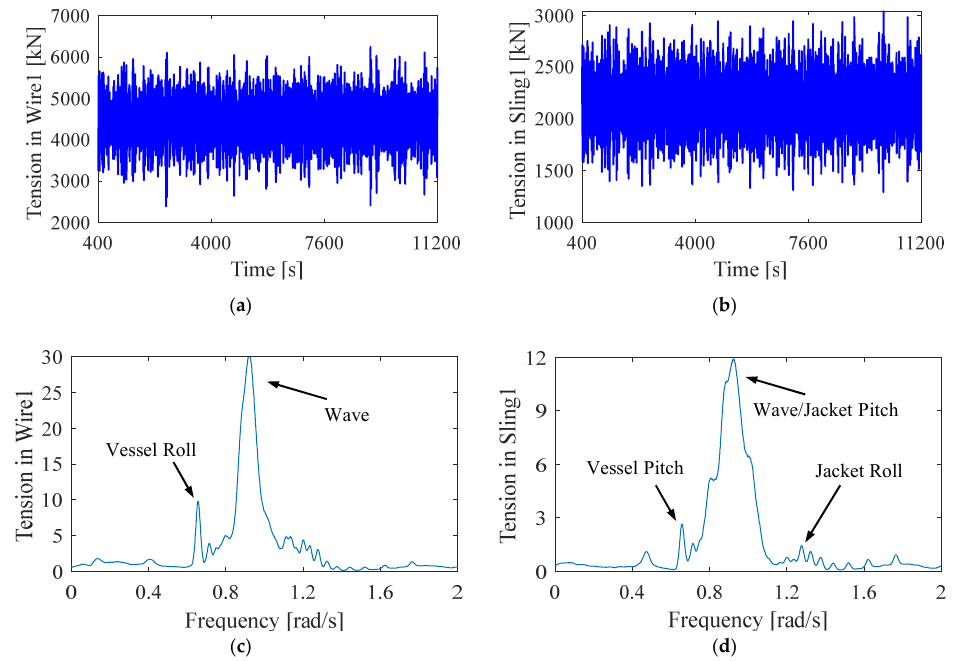
Figure 15. Response time series and PSD of tension of the Sling1 and Wire1 ( H s = 1.5 m, T p = 7 s, Dir = 45 deg, JL1-Z3). ( a ) Time series of wire1 tension; ( b ) Time series of sling1 tension; ( c ) PSD of wire1 tension; ( d ) PSD of sling1